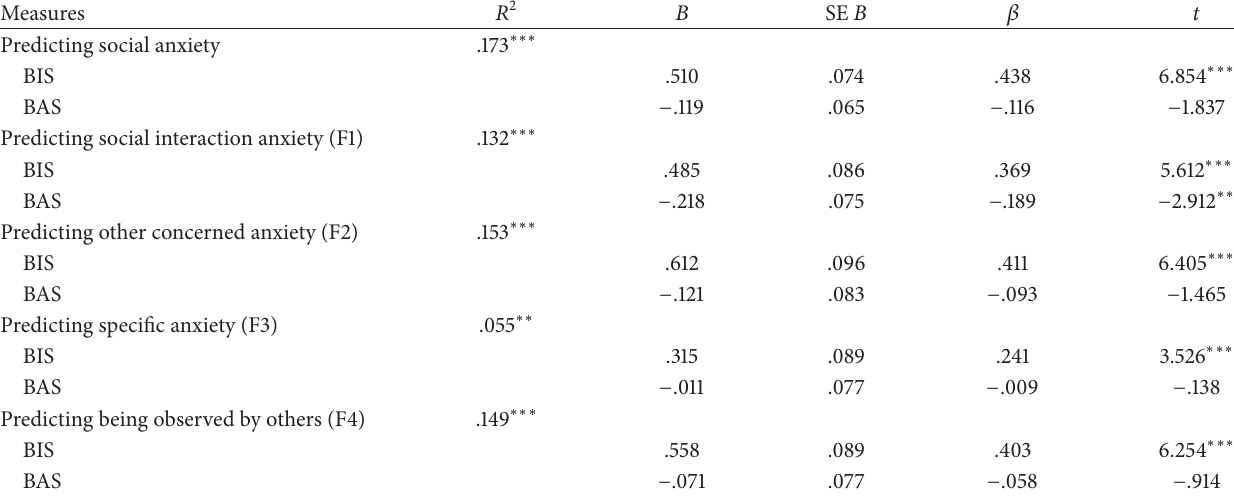
Table 5: Specificity of factors of BIS/BAS in predicting social anxiety and its four factors. Measures 𝑅 2